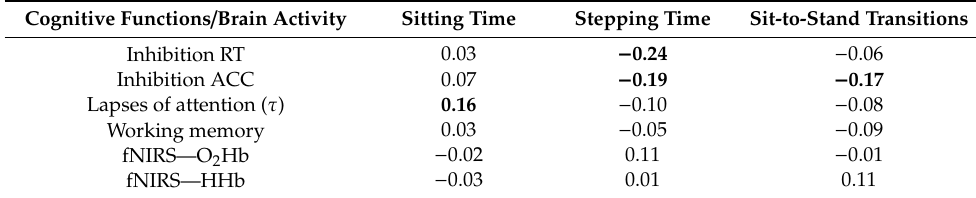
Table A2. Pairwise Pearson’s correlation coe ffi cients between sitting, standing and stepping data, and cognitive functions and brain activity